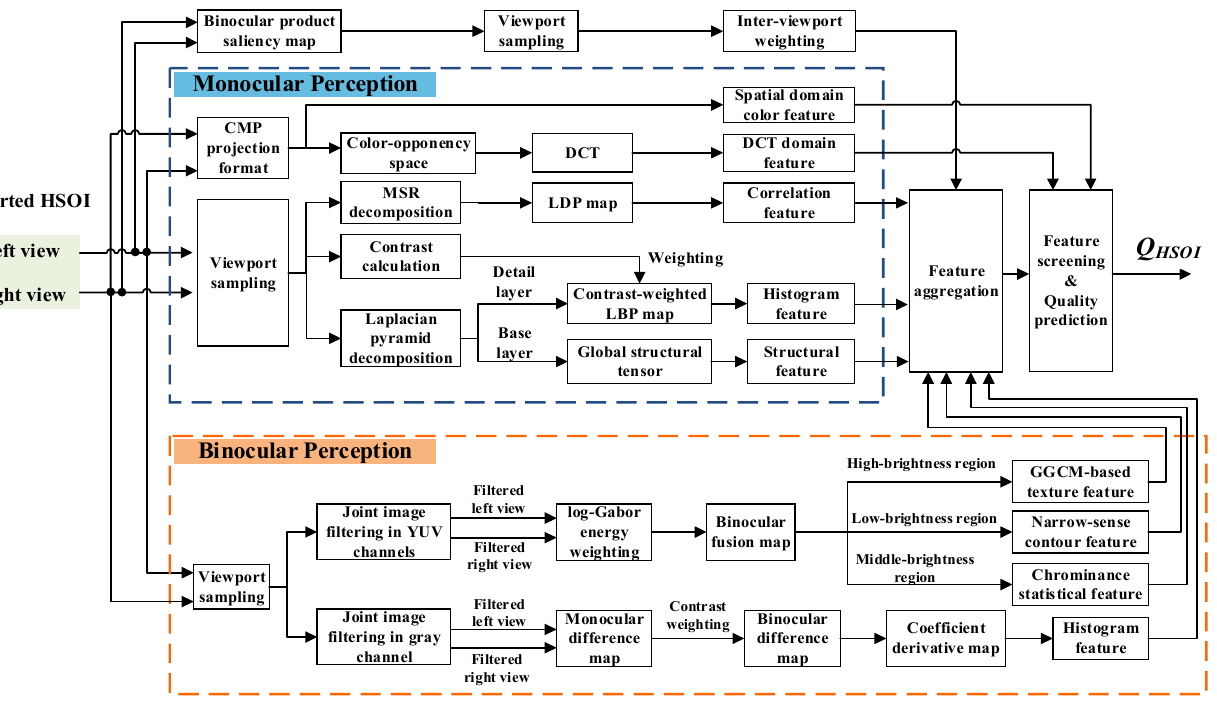
Figure 2. The framework of the proposed HSOIQA metric for the client in the HSOV